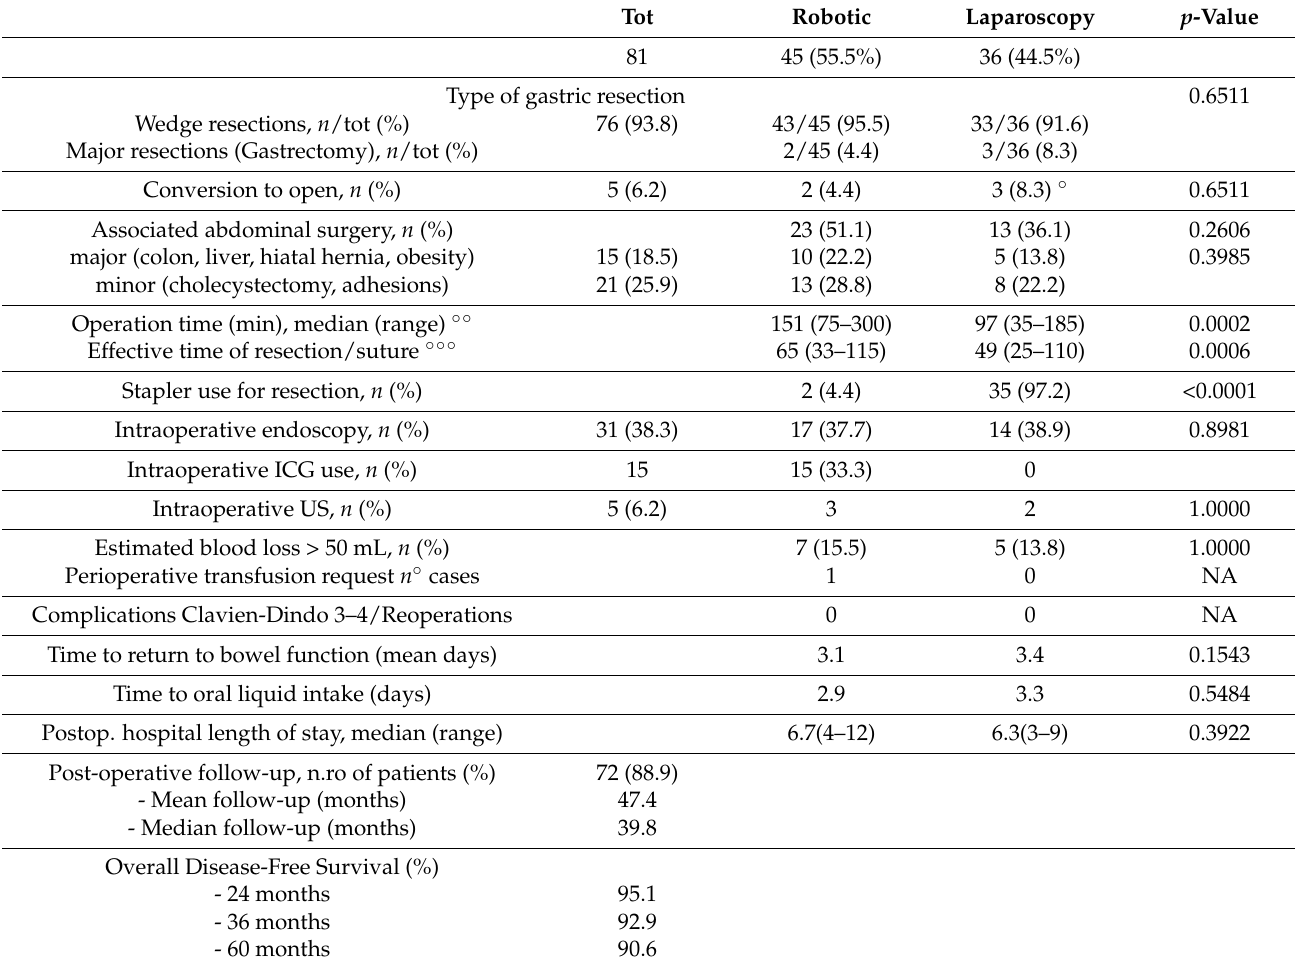
Table 3. Operative and perioperative outcomes in the two series.